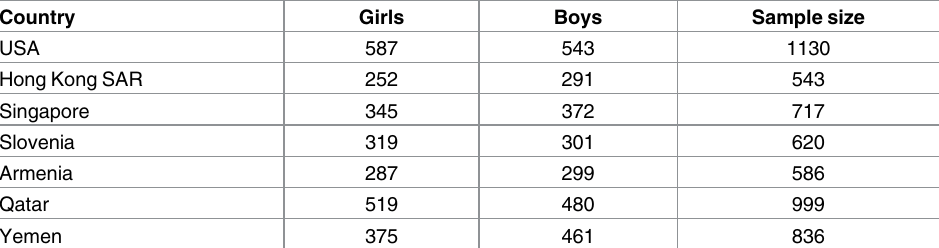
Table 2. Sample size in each country.